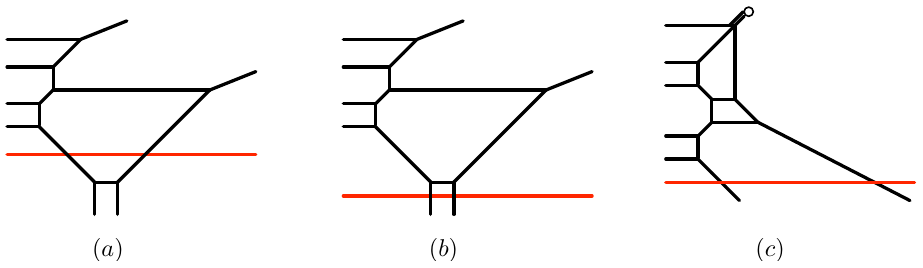
Figure 8 . Different unHiggsed 5-brane configurations for SU(2) gauge theory with 4 fla- vors and defects, associated with different global symmetries: (a) SU(4) × SU(2) × SU(2), (b) SU(4) × U(1) × SU(2), and (c) SU(5) × U(1). The red lines are D5-branes where the defect Higgs- ing is applied. A white dot is